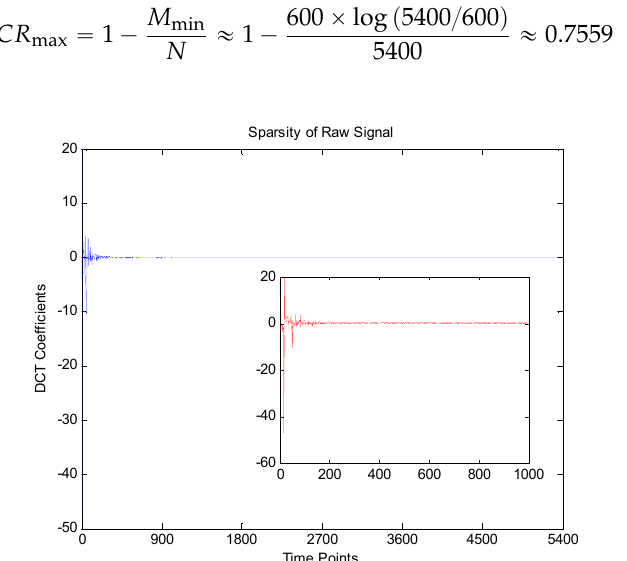
Figure 9. Sparsity of raw accelerometer signal (axis X1).